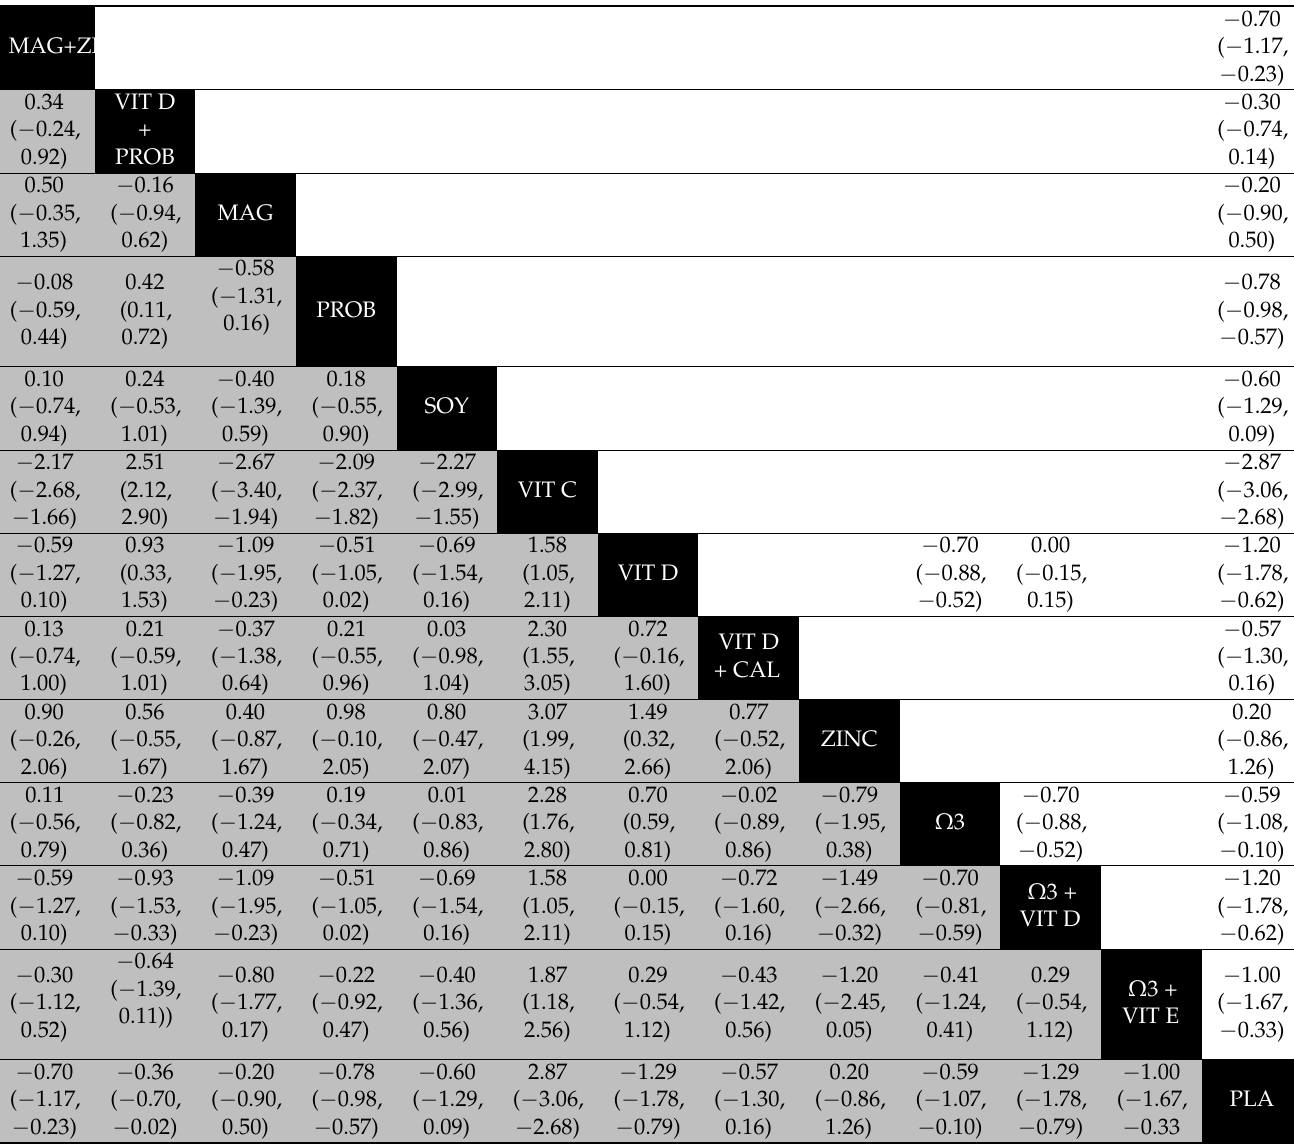
Table 6. Direct and indirect (in grey) estimates of the mean difference of MDA. Each column presents a different